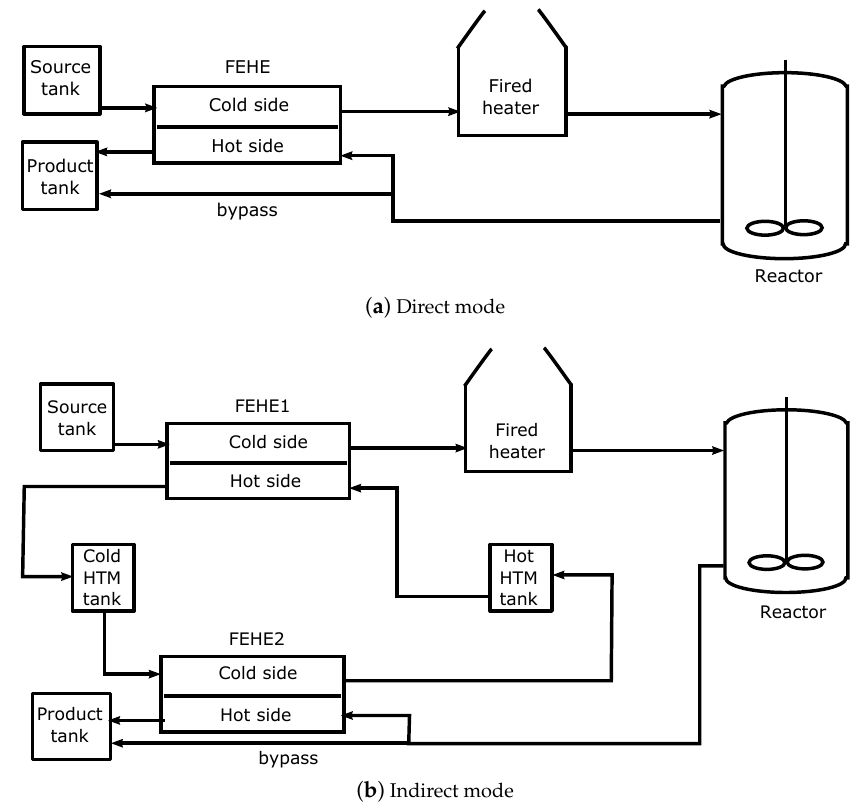
Figure 1. Energy-integrated Batch Reactor-Feed Effluent Heat Exchanger (BR-FEHE) system (HTM: Heat transfer